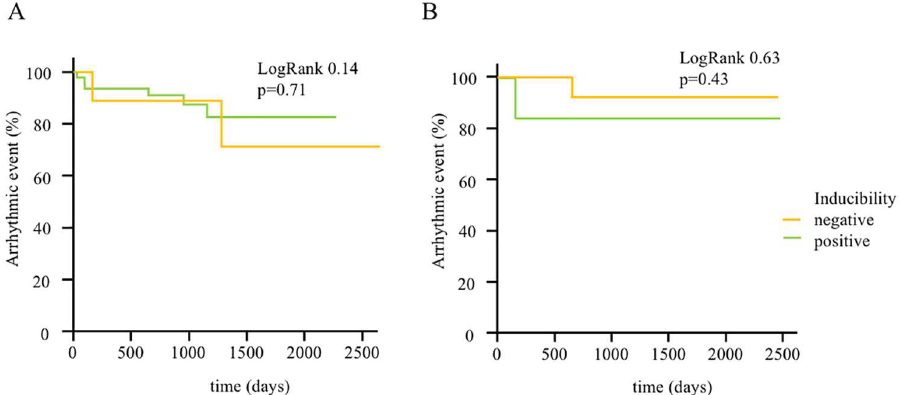
Fig 4. Kaplan-Meier-Curves for the occurrence of primary endpoints stratified by inducibility in programmed ventricular stimulation in all patients (A) and in a subgroup of patients with low inflammatory activity (B). A. Kaplan-Meier estimates illustrate the occurrence of the primary endpoints hemodynamically relevant sustainedventricular tachycardia and/or adequateICD-therapy(antitachycardia pacing,shock) for all enrolledpatients duringfollow-up. There is no significantdifference betweeninducible and non-inducible patients regardingthe occurrence of ventricular arrhythmia (LogRank0.14, p < 0.71). B. Kaplan-Meier estimates illustrate the occurrence of the primary endpoints hemodynamically relevant sustainedventricular tachycardiaand/or adequateICD-therapy (antitachycardia pacing,shock) duringfollow- up for a subgroup of patients with low inflammatory activity. There is no significantdifference between inducible and non-inducible patients regardingthe occurrence of ventricular arrhythmia (LogRank 0.63, p <